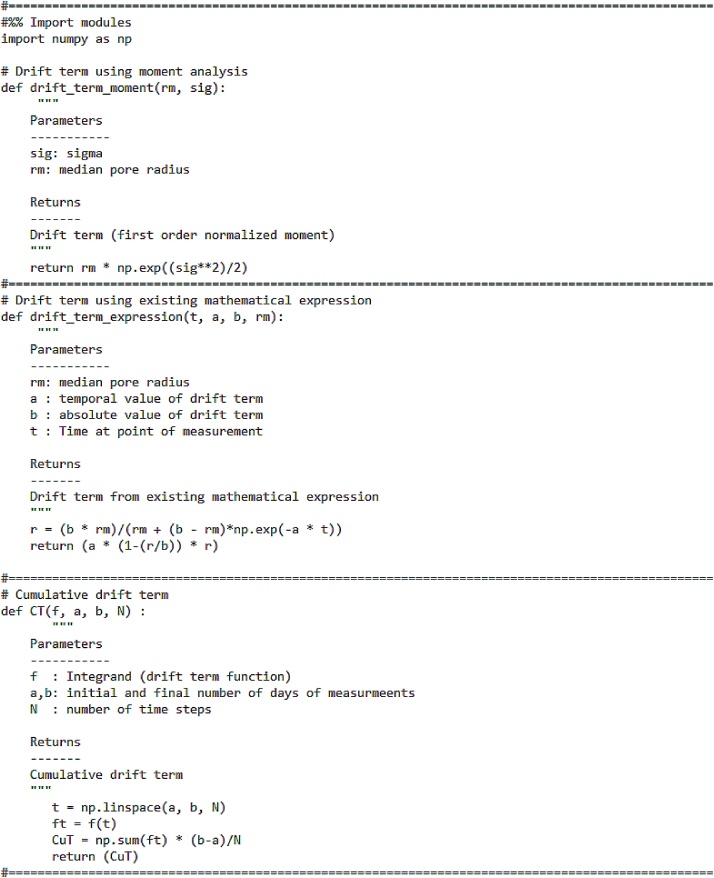
Code for drift term.